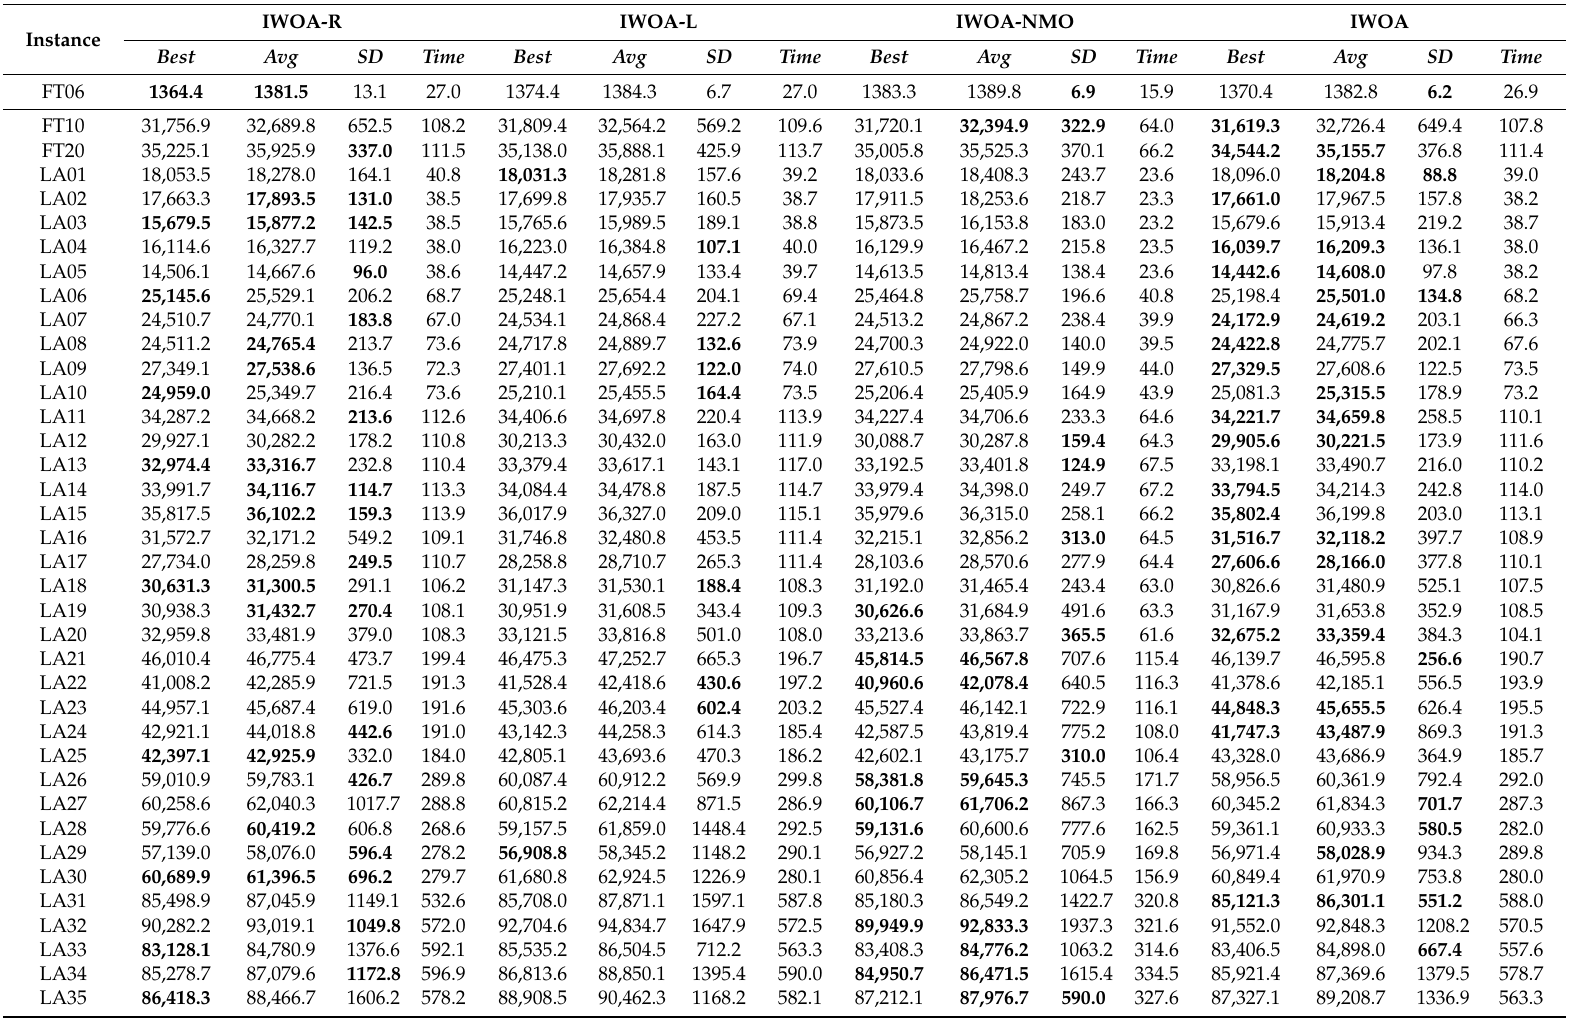
Table 1. Effectiveness analysis of improvement